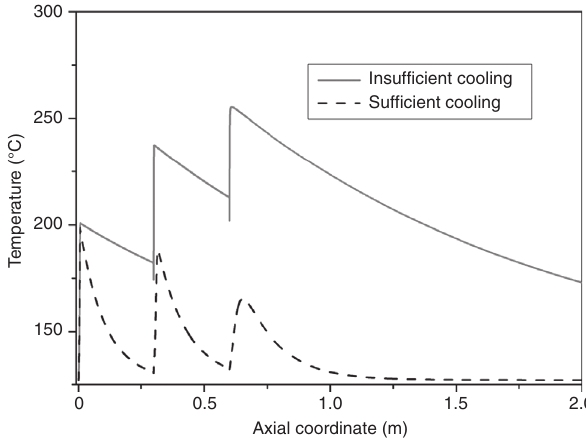
Figure 5 Comparison of a temperature profile with three injections with sufficient cooling and with insufficient cooling between the = L = L injection points ( L 1 2 3